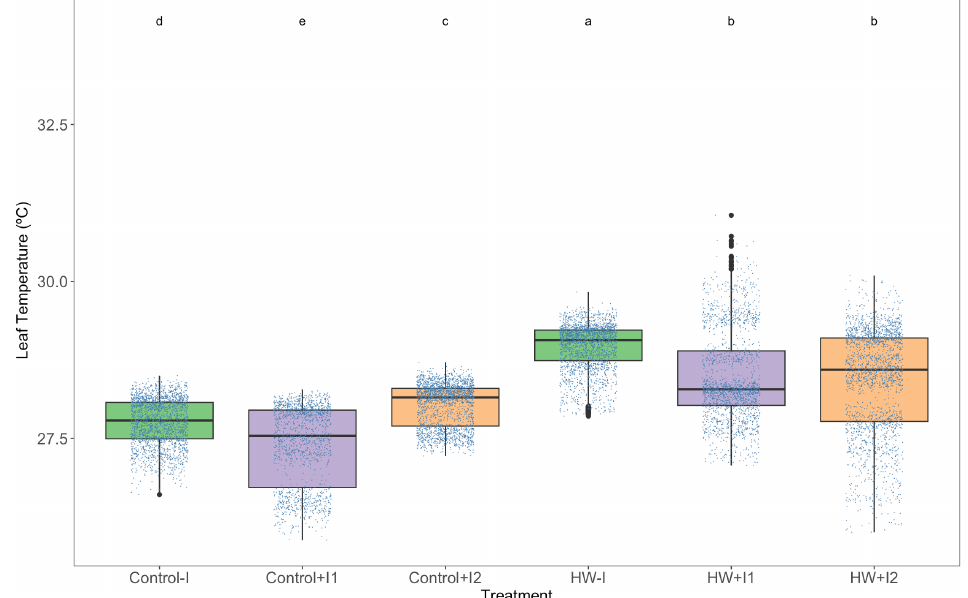
Figure 2. Leaf surface temperature measured through infrared thermography of non-inoculated ( − I) and marine PGPR consortia 1- and 2-inoculated (+I) Vitis vinifera plants, under normal (control) thermal regimes and exposed to the heatwave (HW) (average ± standard deviation, N = 5, letter denotes significant differences at p < 0.05).